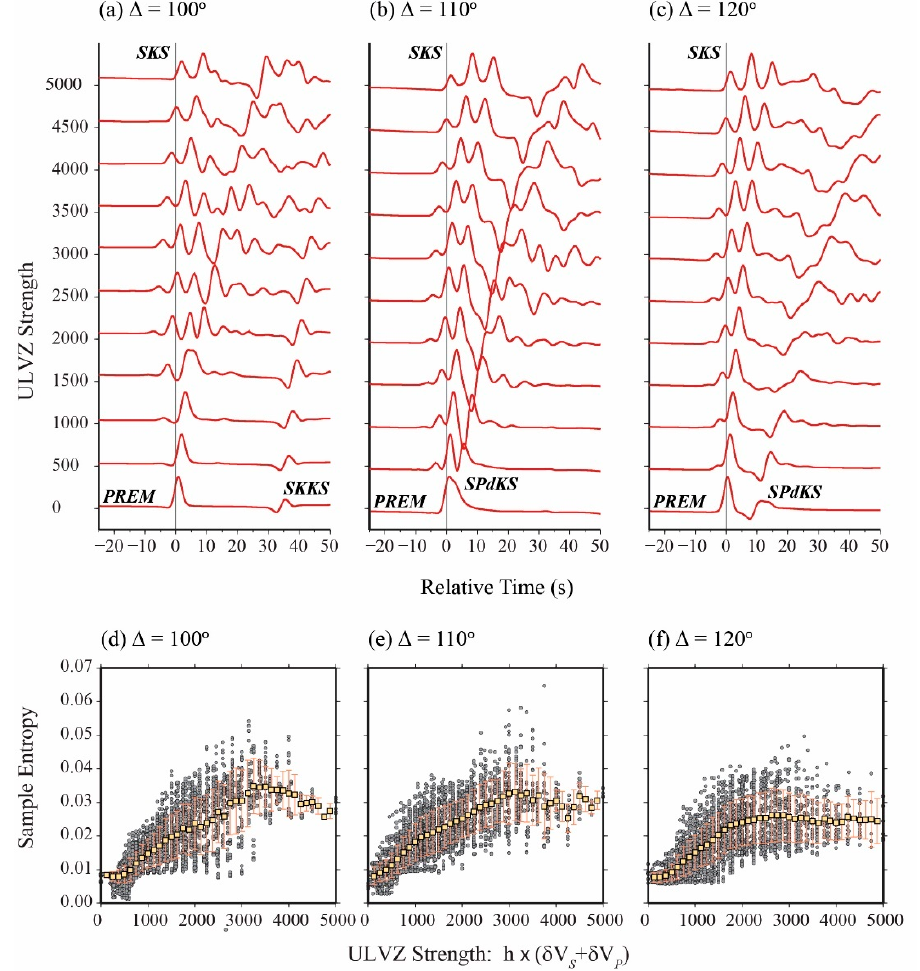
Figure 3. Example synthetic seismograms for 1-D models of ULVZs at epicentral distances of ( a ) 100°, ( b ) 110°, and ( c ) 120° are shown. All synthetics are radial component displacement synthetics aligned on the PREM predicted SKS arrival time and normalized in amplitude to unity. Seismograms are organized from low to high ULVZ strength from bottom to top. Synthetics shown are for models that all have ULVZ thickness (h) = 50 km, and δρ = +10%. The bottom trace (PREM) has δ V S = − 0% and δ V P = − 0%. Each trace going upward has an additional decrease in δ V S and δ V P of 5%. For example, the 2nd trace from the bottom has δ V S = − 5% and δ V P = − 5%. The 3rd trace from the bottom has δ V S = − 10% and δ V P = − 10%. The top-most trace has δ V S = − 50% and δ V P = − 50%. The sample entropy of all 1-D ULVZ models are shown at epicentral distances of ( d ) 100°, ( e ) 110°, and ( f ) 120°. The individual measurements are shown with gray circles, and the average (yellow squares) and 1– σ range (red bars) are shown in windows of ULVZ strength of 250%·km.